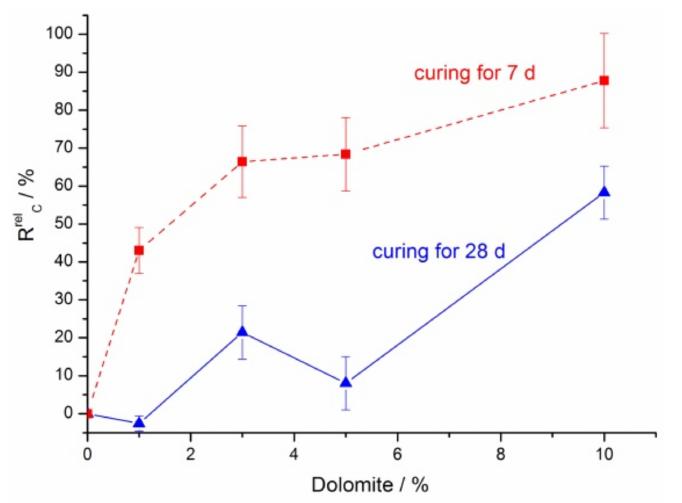
Figure 5. Relative increment of dolomite addition in the strength of geopolymers (R rel C ) based on the FA + dolomite blends at the age of 7 and 28